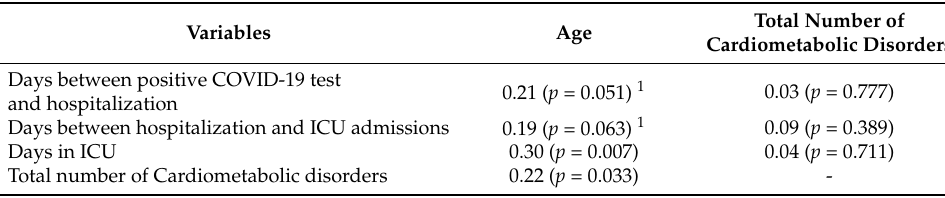
Table 2. Nonparametric measures of association between variables.